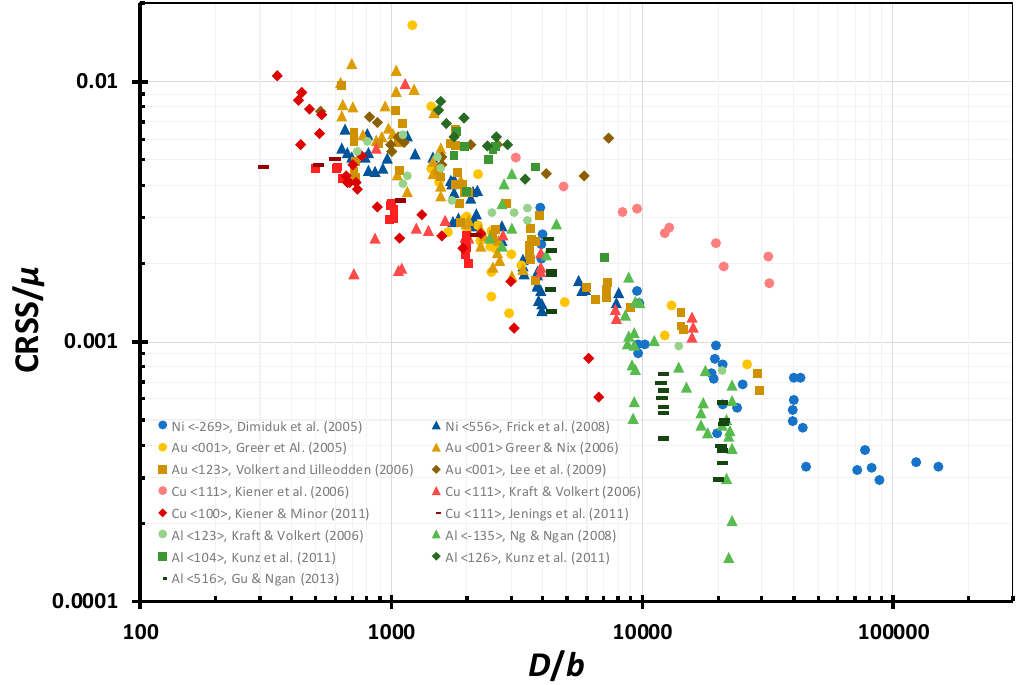
Figure 3. Variation of the critical resolved shear stress normalized by the shear modulus versus the sample diameter normalized by the Burgers vector in FCC metals. The original experimental data have been reported by Dimiduk et al. [25], Greer et al. [26], Greer and Nix [27], Volkert and Lilleodden [28], Kiener et al. [29], Kraft and Volkert [30], Frick et al. [31], Ng and Ngan [32], Lee et al. [33], Jennings